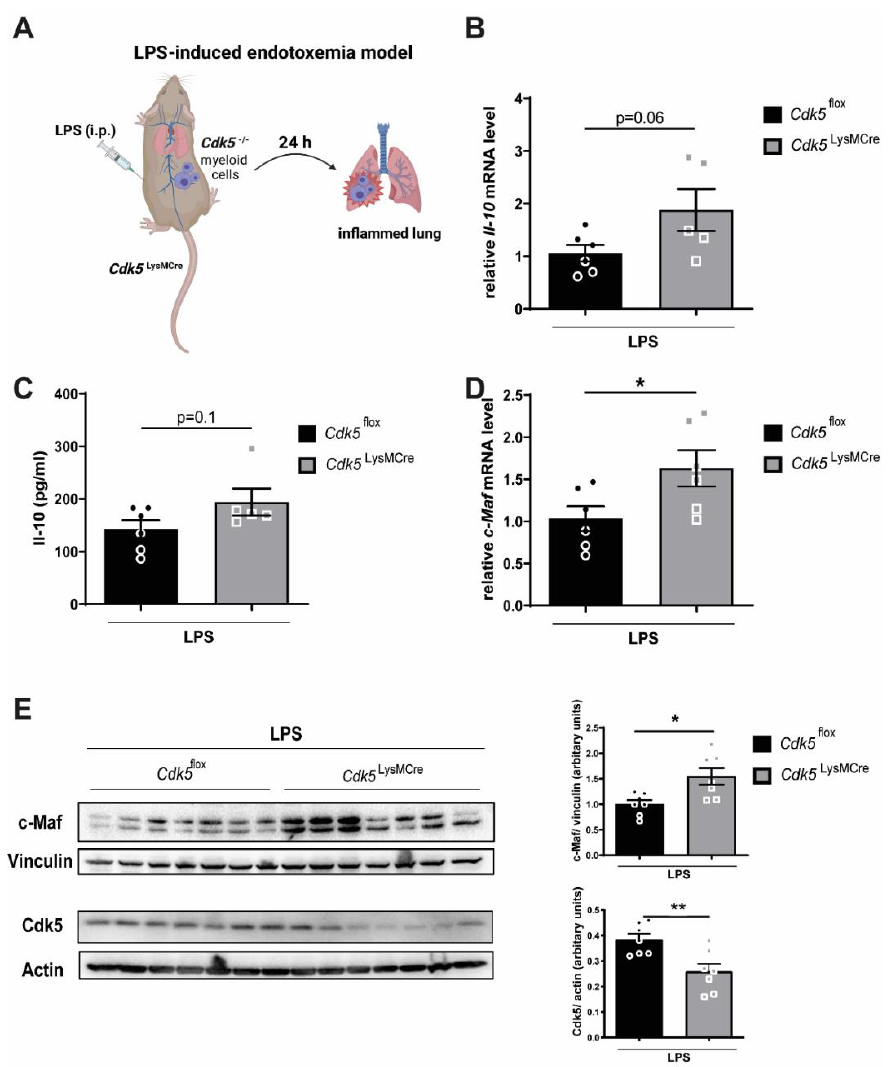
Figure 3. Myeloid-specific Cdk5 deletion leads to increased c-Maf and hence Il-10 levels in the lung of mice during LPS-induced endotoxemia. ( A ) Schematic representation of the experimental setup for LPS-induced endotoxemia (LPS dose: 15 mg/kg) created with BioRender.com. ( B ) Il-10 mRNA expression in homogenized lung tissue from endotoxemic Cdk5 flox and Cdk5 LysMCre mice after 24 h was determined by qRT-PCR ( C ) Il-10 concentration was measured in bronchoalveolar lavage (BAL) of endotoxemic Cdk5 flox and Cdk5 LysMCre mice after 24 h by ELISA ( D , E ) homogenized lung tissue from endotoxemic Cdk5 flox and Cdk5 LysMCre mice after 24 h was analyzed for ( D ) c-Maf mRNA expression and ( E ) c-Maf protein expression. c-Maf protein (42 kDa) and vinculin (117 kDa) as loading control as well as Cdk5 (30 kDa) and Actin (42 kDa) as loading control were detected by